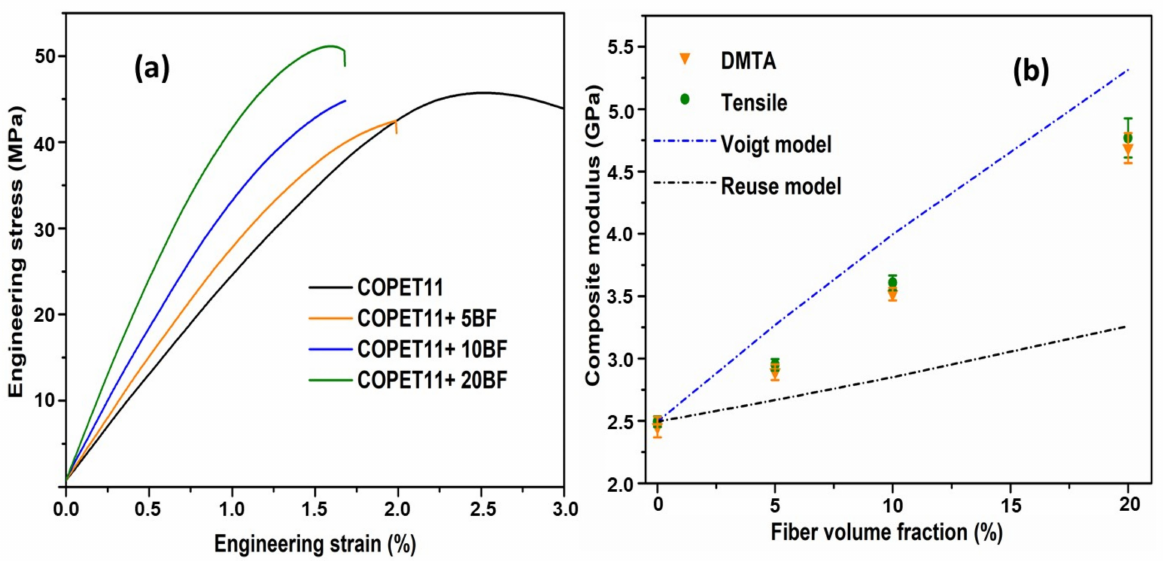
Figure 12. Tensile properties of neat COPET11 and banana fibre composites at 25 ◦ C as a function of the fibre fraction. ( a ) Experimental stress-strain curves, ( b ) experimental and Young’s modulus vs. fibre content, compared with Voigt and Reuss